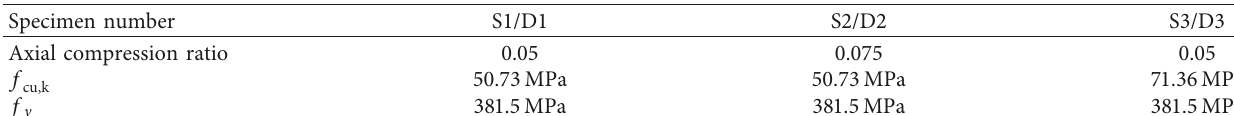
Figure 4: Test system and loading device. (a) Test setup overview. (b) Axial force loading device. (c) Horizontal force loading device. Table 1: Parameters of specimens.